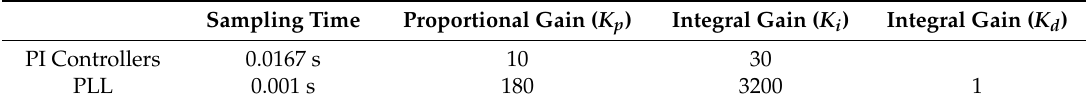
Table 2. Gains of the PI controllers and phase-locked loops